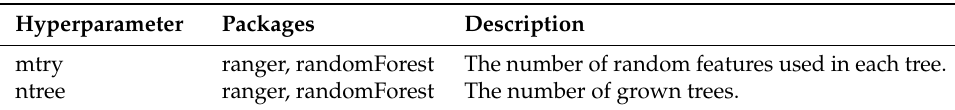
Table 2. Random forests